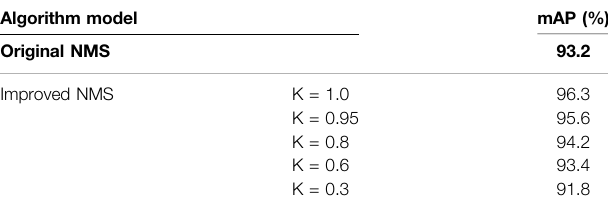
TABLE 5 | NMS algorithm optimization validation for logical element recognition. Algorithm